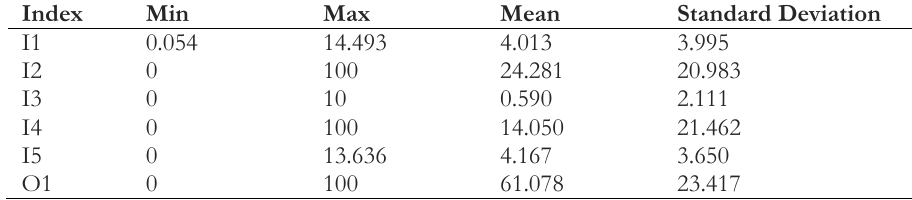
Table 4. Statistical information related to the data